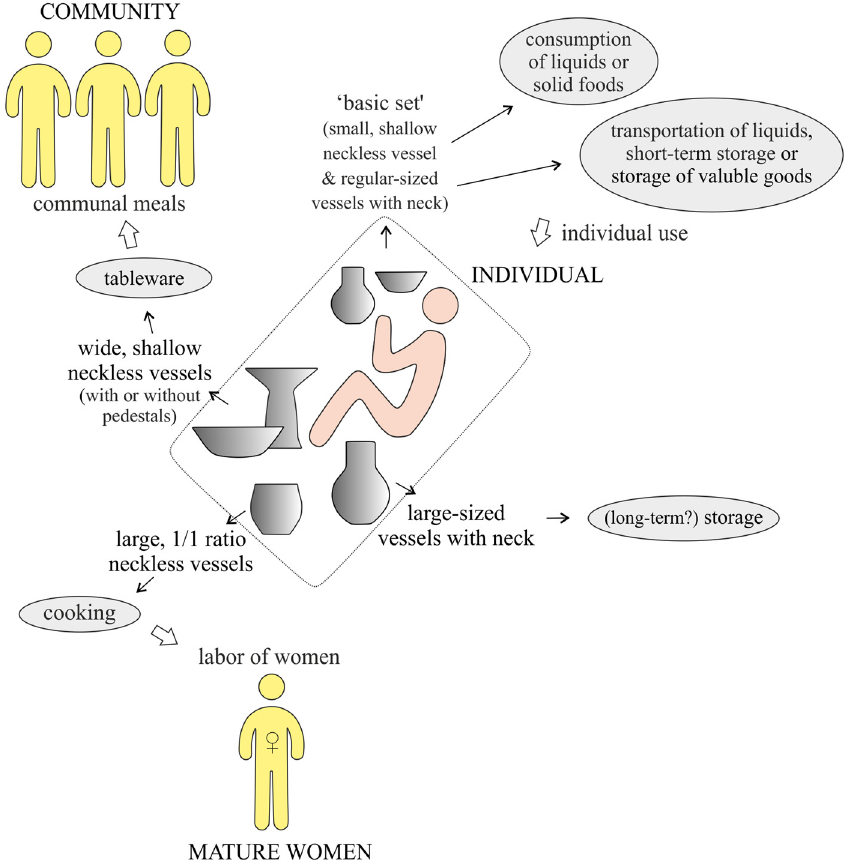
Figure 11: The di ff erent ceramic morphometric categories and their possible function in Early Copper Age